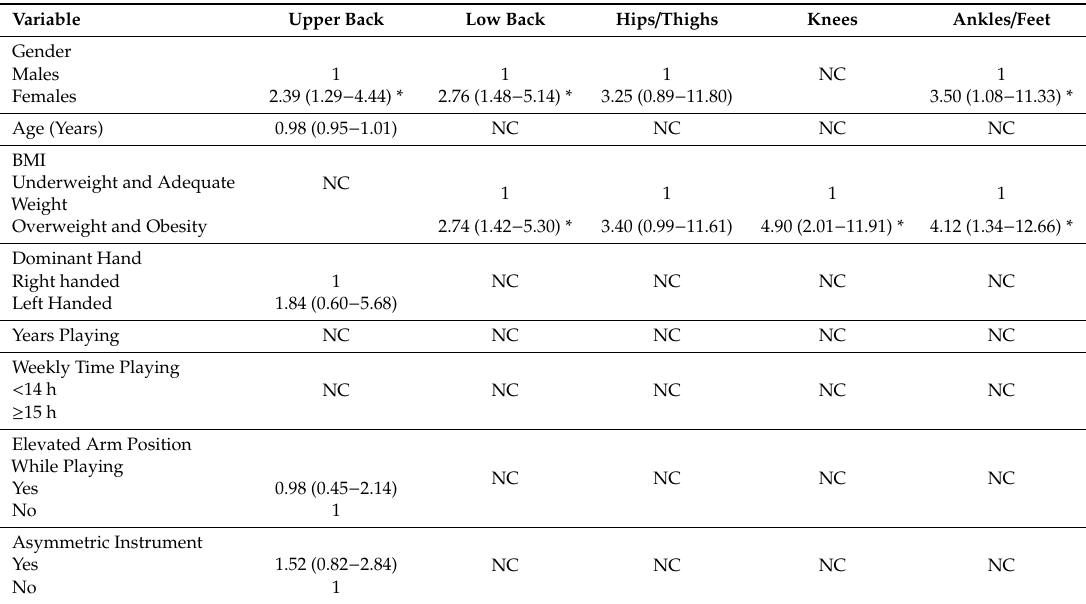
Table 8. Factors associated with pain in back and lower